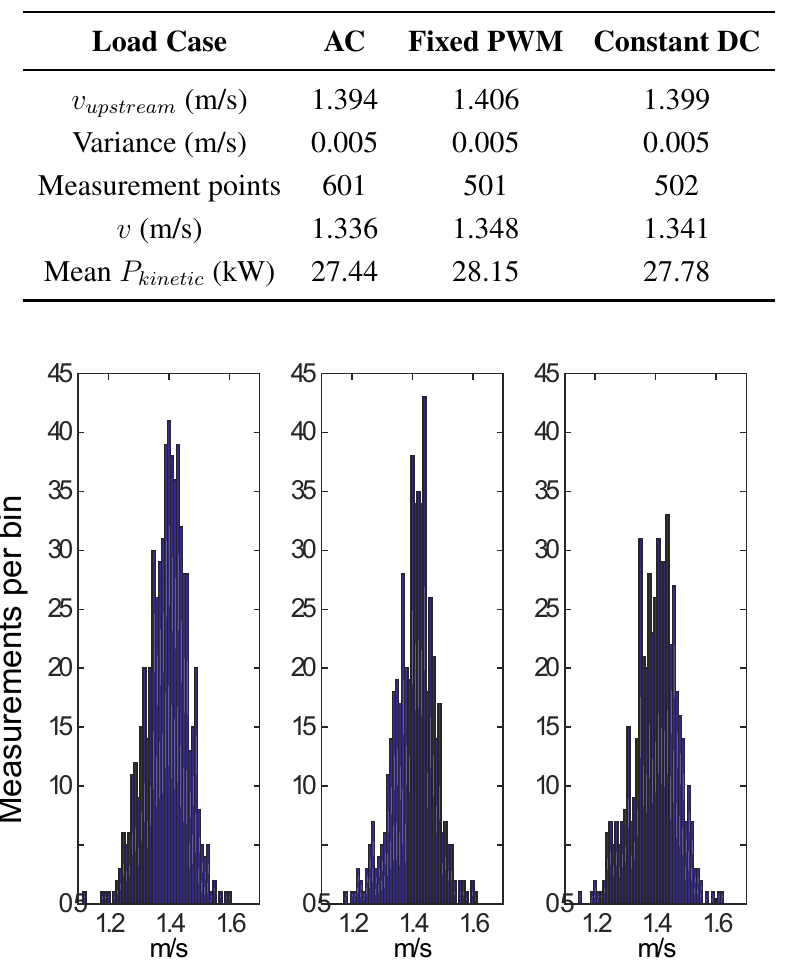
Table 1. Average velocity measured by the ADCP and calculated average power across the turbine at the respective speeds.